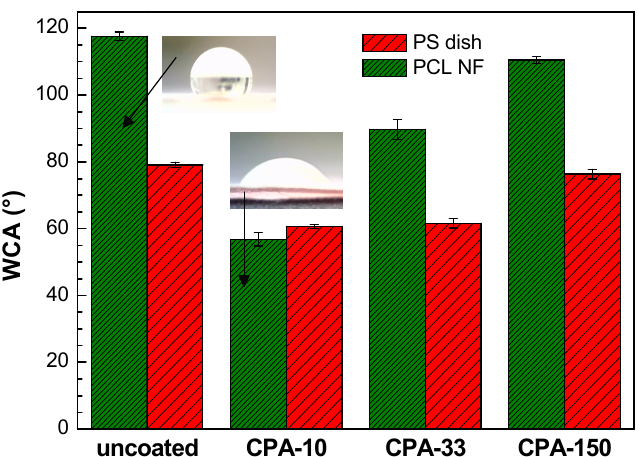
Figure 3. Water contact angle (WCA) values on uncoated and PP-coated PS dishes and on PCL NFs aged for two weeks. CPA-10, CPA-33, CPA-150: PPs were deposited at the average RF power ( P av ) of 10, 33, and 150 W, respectively.